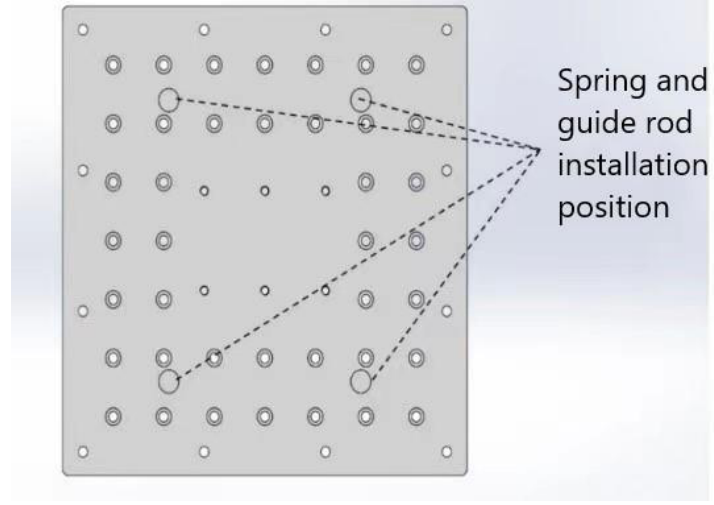
Figure 2. Installation position of spring and guide rod.